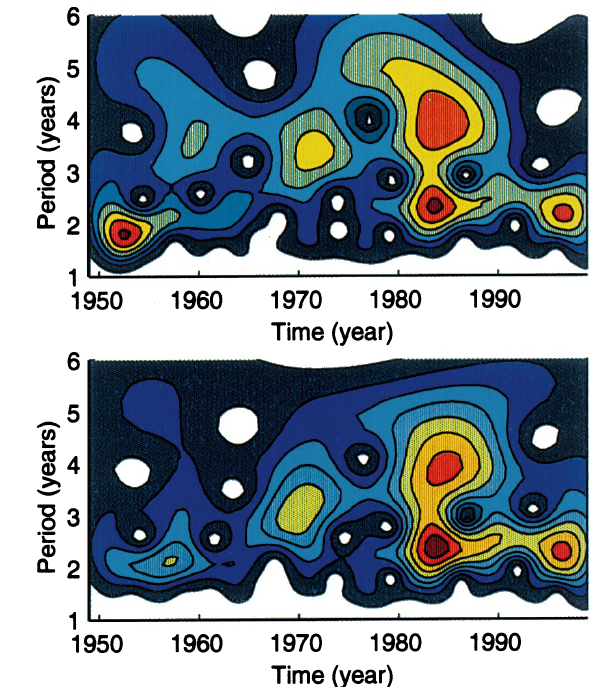
Fig. 7a, b. Amplitude diagram of the wavelet transform of a LOD, b AAM (i.e. NCEP 10 ). Contours at 0.01 ms intervals W